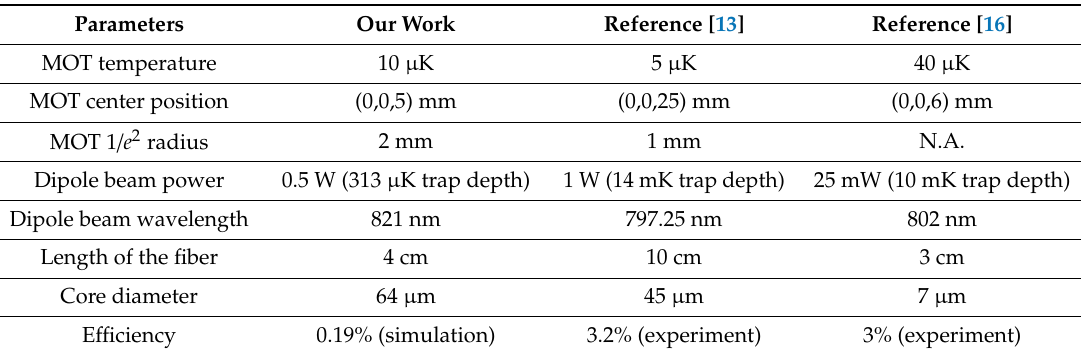
Table 1. A list of the reference parameters for the simulation and comparison with other